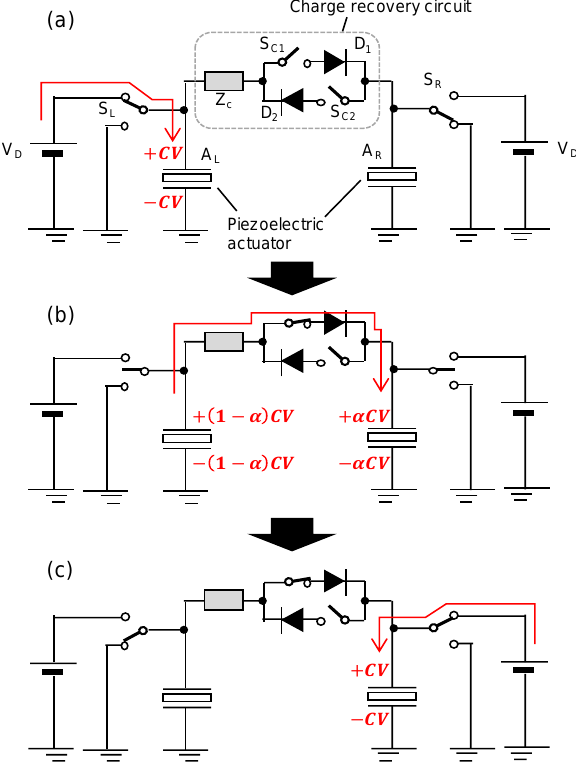
Figure 2. Conventional charge recovery circuit: ( a ) left actuator is charged by the direct current (DC) source; ( b ) charge is transferred to the right actuator through the charge recovery circuit; ( c ) right actuator is charged by the DC